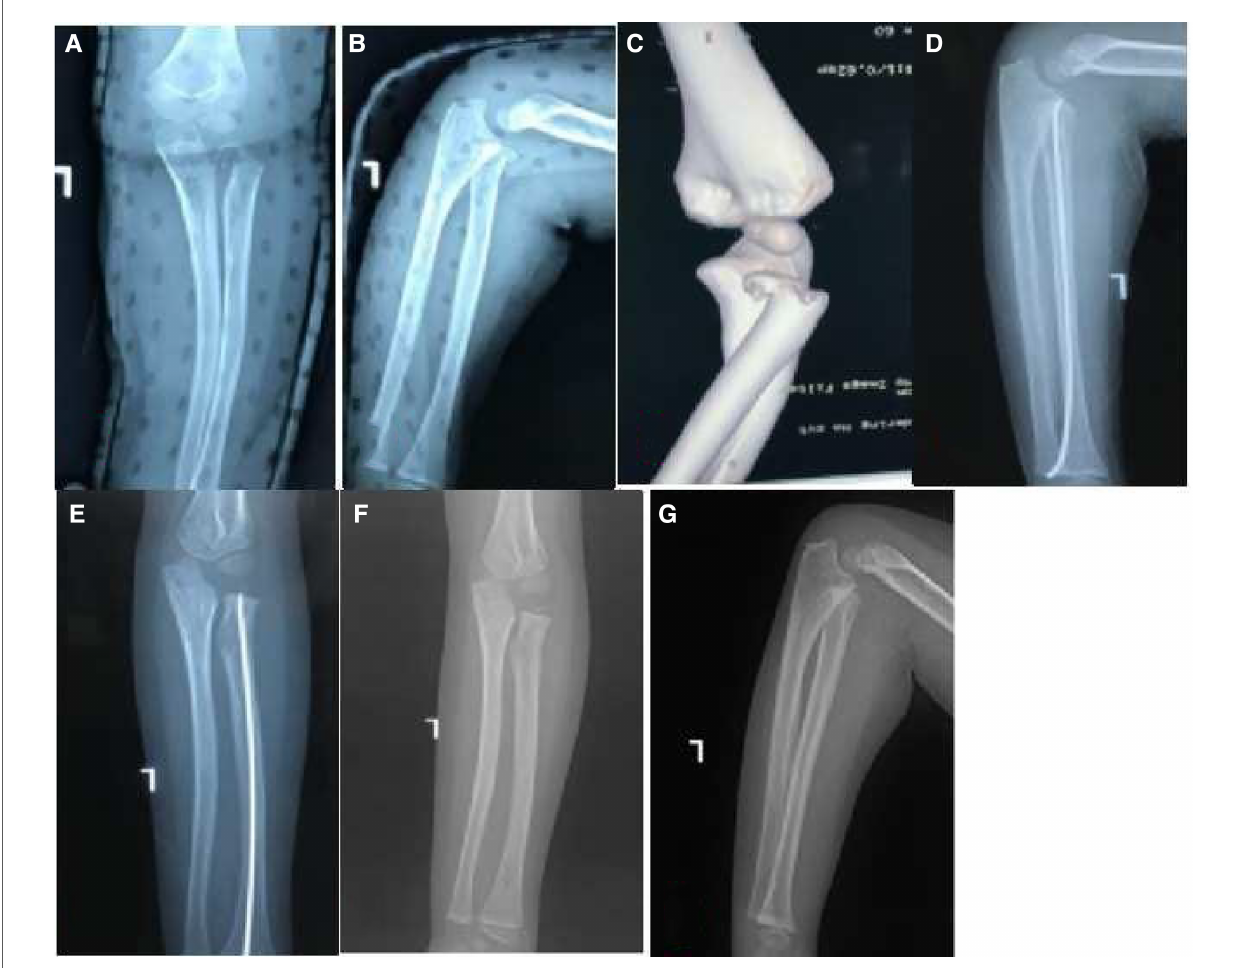
FIGURE 3 A 5-year-old girl with a head – neck separation type of Monteggia equivalent fractures ( fl exion-varus type) ( A – C ). No treatment for ulna greenstick fracture, closed reduction with elastic intramedullary nail for radial neck fracture ( D,E ). The last follow-up was 3 years after surgery ( F,G